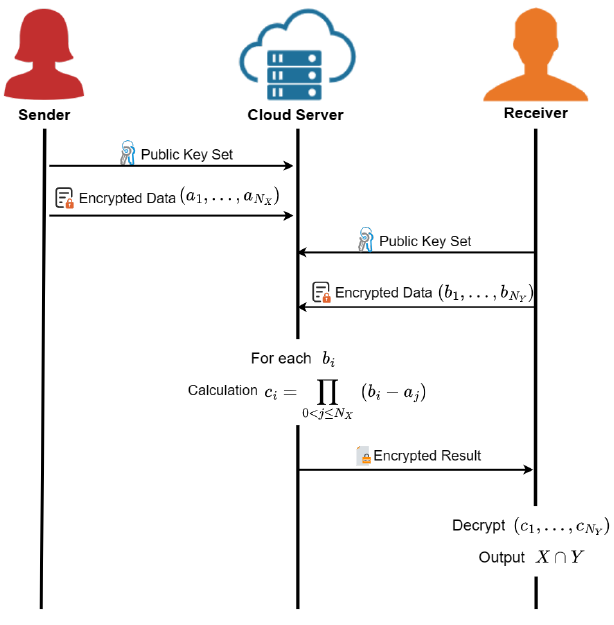
Figure 2. Handshake